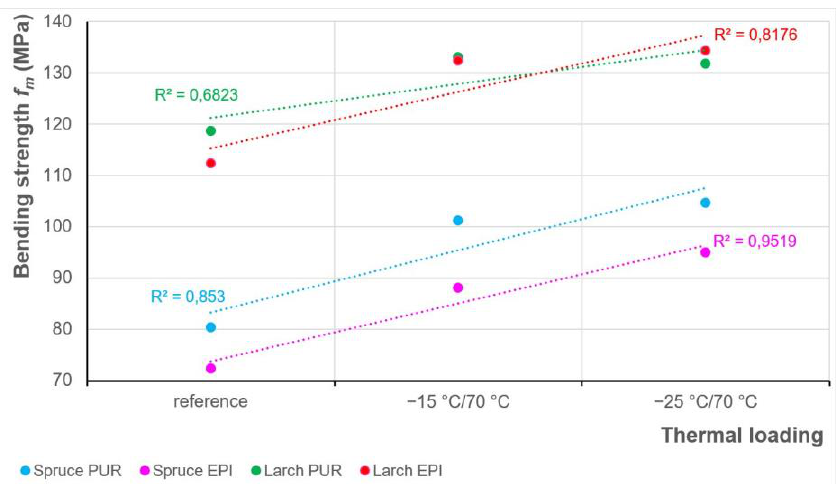
Figure 8. Correlation between bending strength and thermal loading.